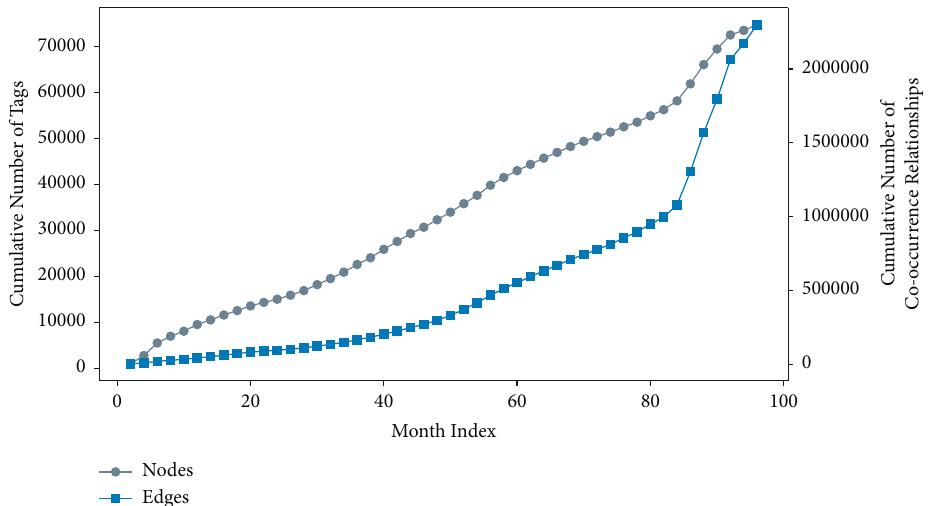
Figure 2: The cumulative number of tags (left) and relationships